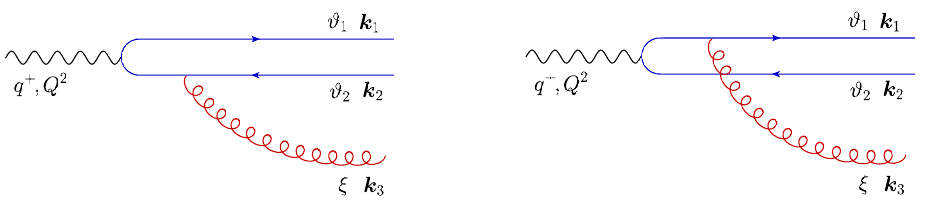
Figure 2 . Feynman graphs in light-cone perturbation theory describing the quark-antiquark-gluon fluctuation of the virtual